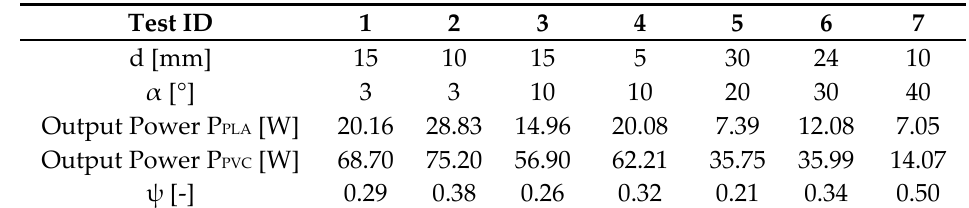
Figure 6. Power delivered in tests performed with the commercial turbine (PVC) and printed turbine (PLA). Table 1. Operating parameters “d” and “ α ” from each test. Power delivered from the commercial P PVC and the built P PLA turbines was